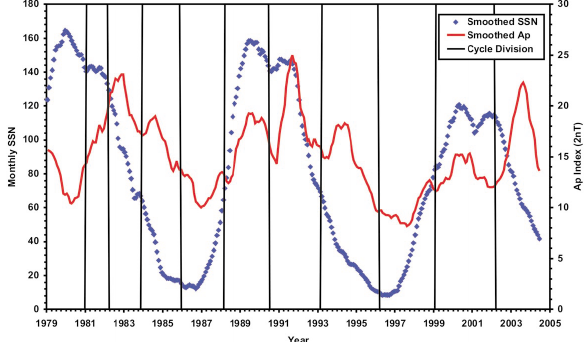
Fig. 3. The solar and geomagnetic activity cycle as represented by smoothed sunspot number (SSN) and smoothed planetary activity index Ap respectively. The division of the geomagnetic activity cy- cle into four phases (minimum, ascending, maximum and descend- ing) is indicated by vertical